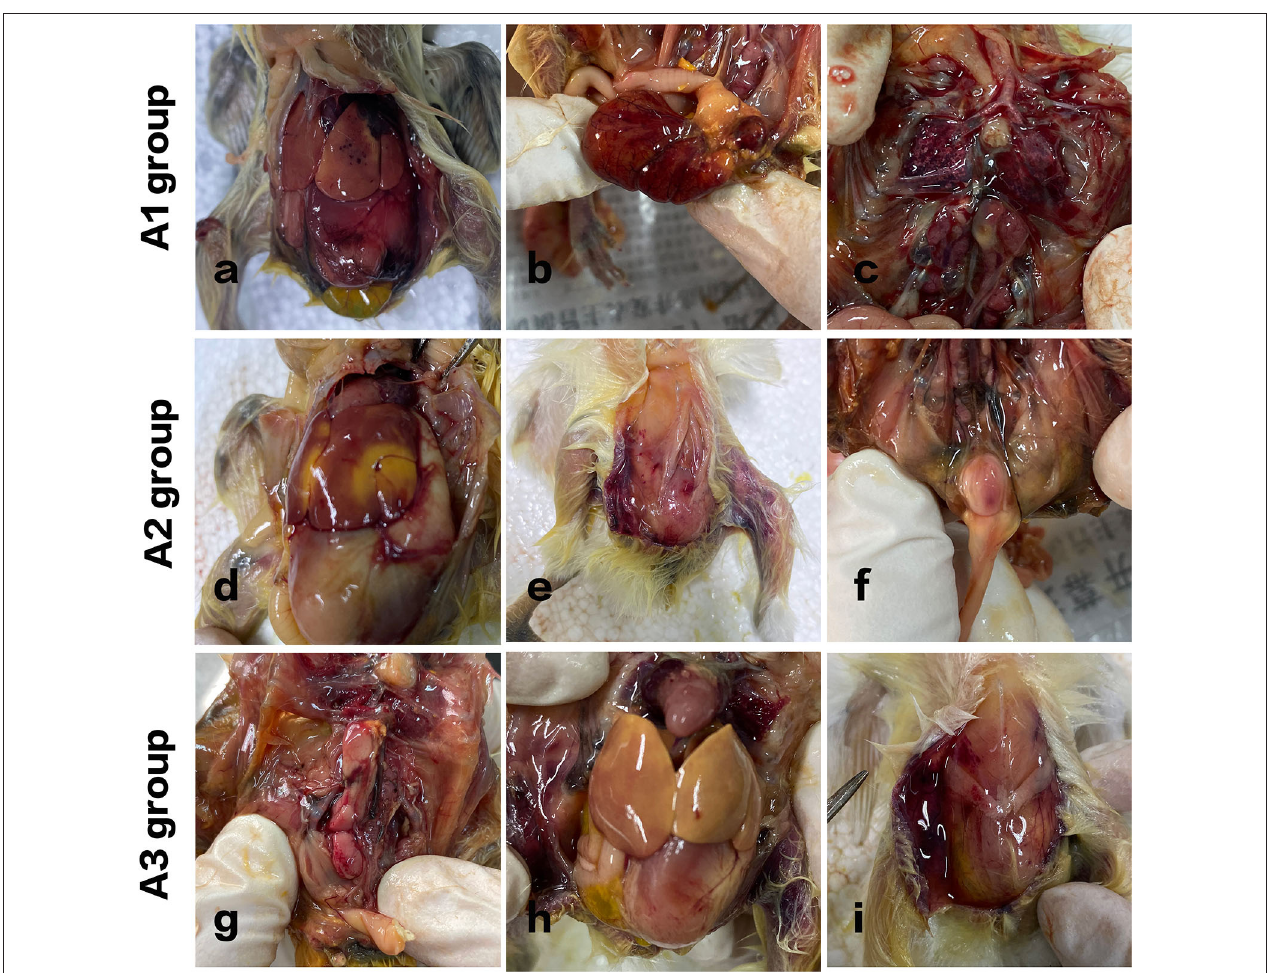
FIGURE 3 | Pathological variation of chicks in different groups. A1 group: Acute septicemia, extensive abdominal bleeding, and redness. (a) Punctate bleeding points on the liver surface were seen. (b) The yolk sac was red and swollen. (c) Hyperemia in flamed lung tissues were seen. A2 group: (d) large yellow plaques and subcutaneous bleeding in the livers of the chickens. (e) Subcutaneous hemorrhage. (f) Enlarged bursa of Fabricius with hemorrhagic spots was observed. A3 group: (g) kidneys were swollen with spotty bleeding. (h) The liver turned yellow. (i) The peritoneum was in a viscous and gelatinous